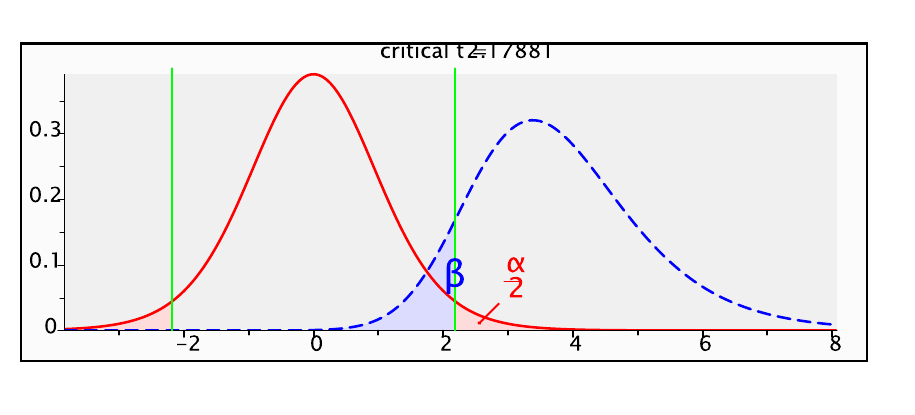
Figure 1. Stability of statistical value at efect size d 1.906; a err prob .05, power (1- b err prob)